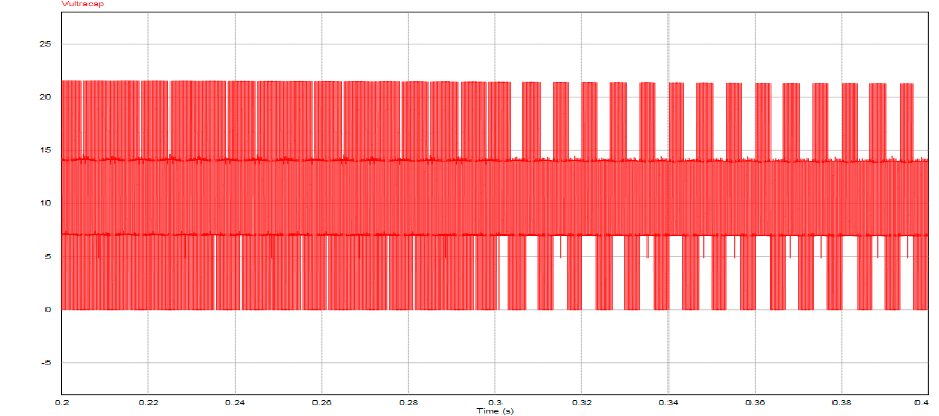
Figure 22. Ultracapacitor voltage.